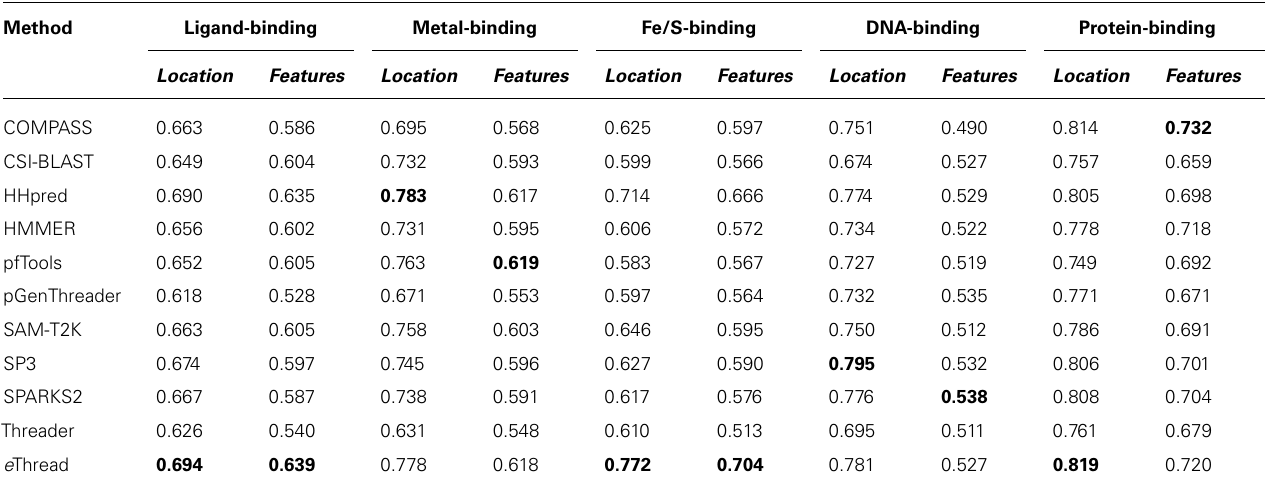
Location and Features as defined in Section “Methods.” Best performing algorithms are highlighted in bold.